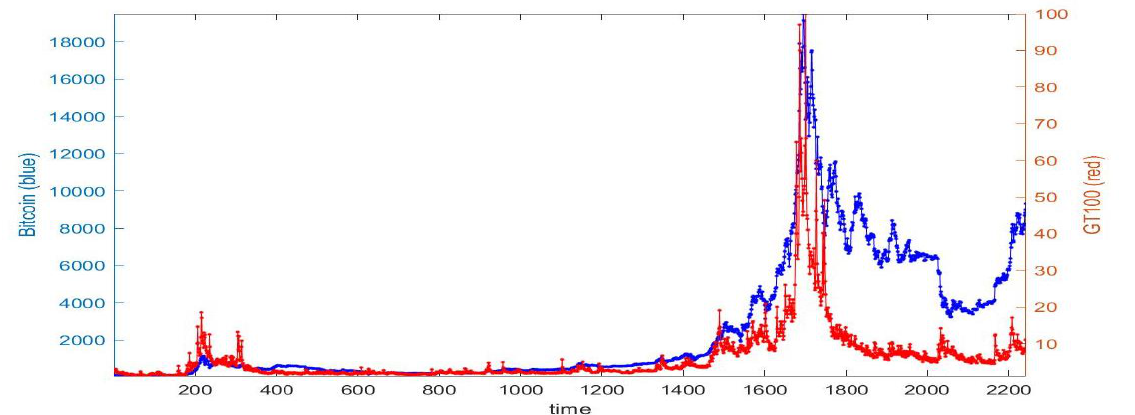
Figure 1. Daily Bitcoin prices (blue color, left scale) and daily Google Trends series (red color, right scale) from 28 April 2013 to 17 June